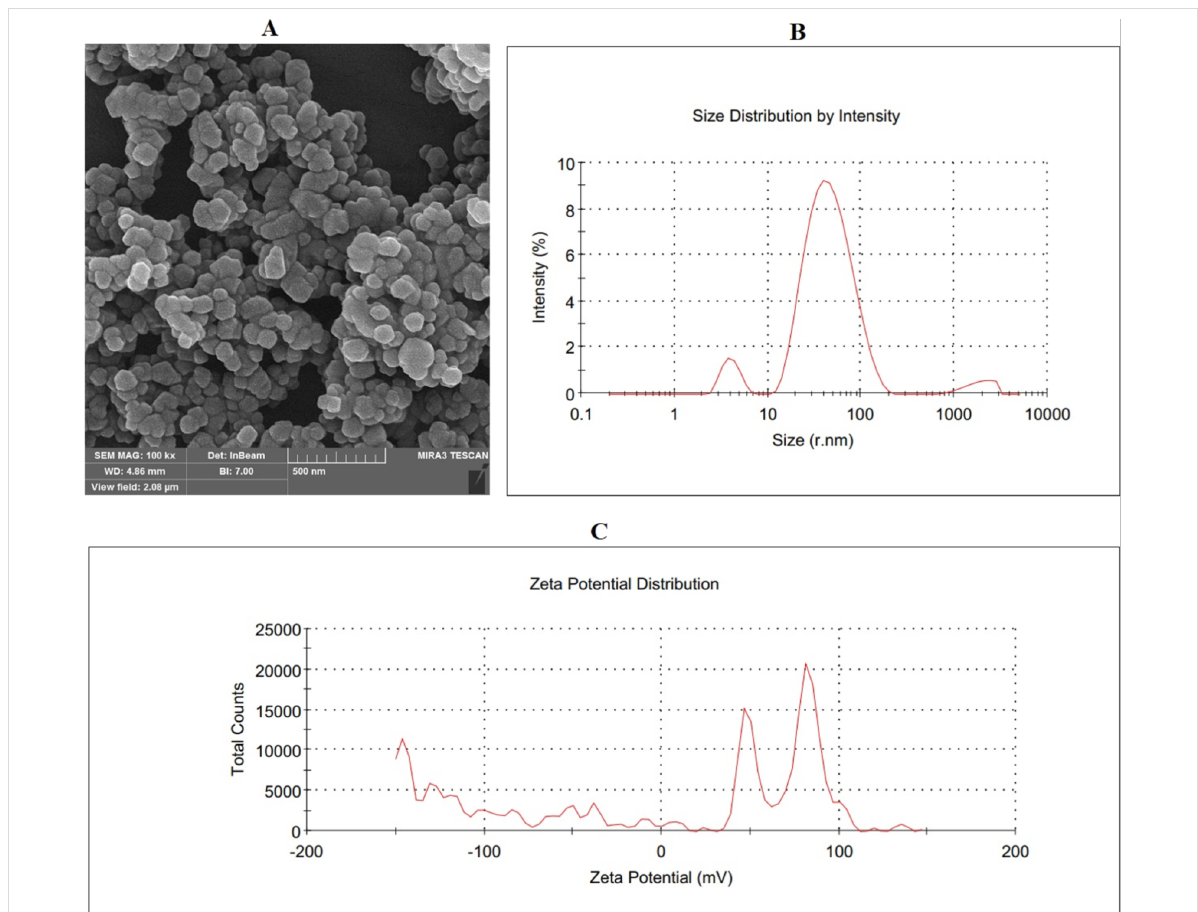
Figure 9: Ag-NPs structure. (A) SEM image of Ag-NPs, (B) size distribution by intensity, and (C) zeta potential distribution.